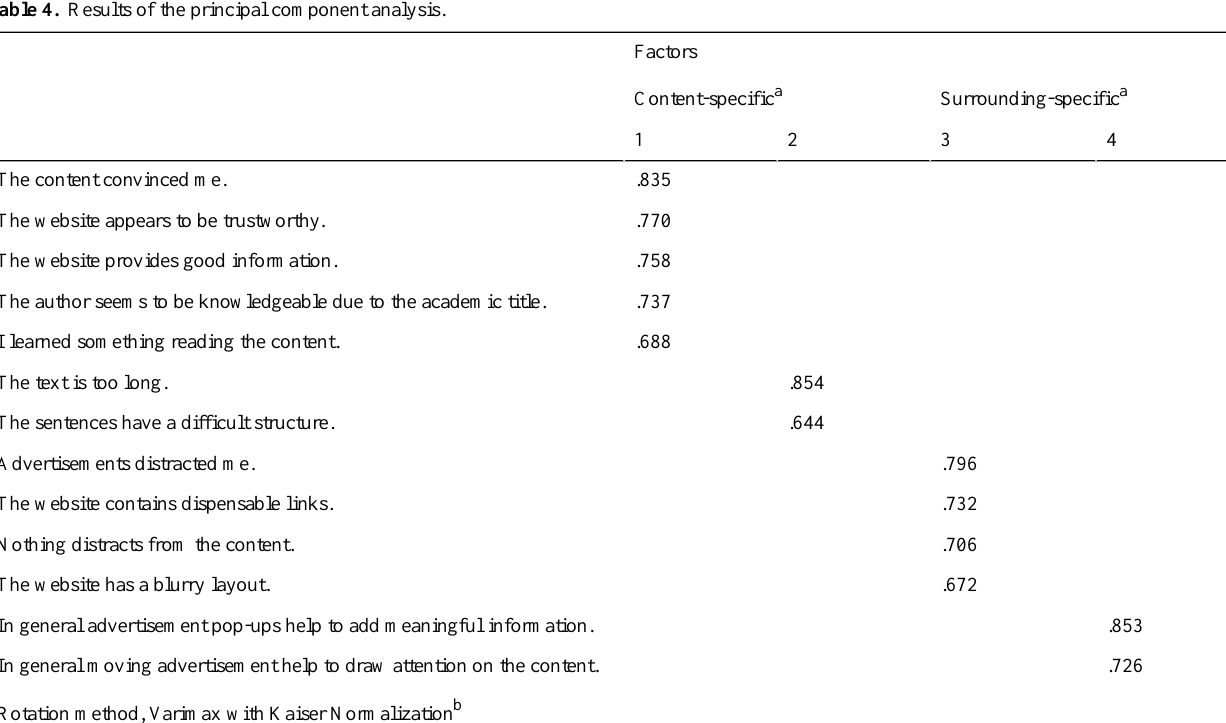
Table 4. Results of the principal component analysis.